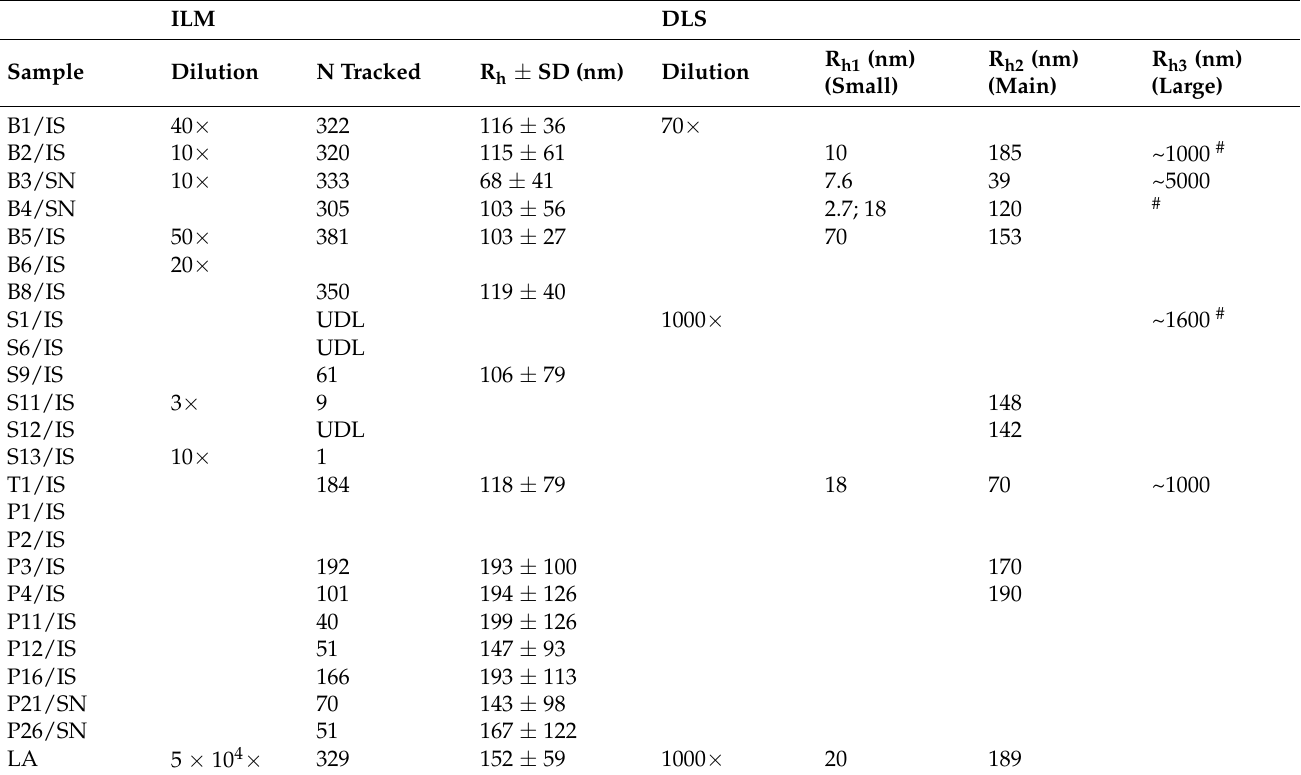
Table 3. Hydrodynamic radii of particles Rh in aliquots of samples B, S, T, P, and L assessed with two methods: ILM and